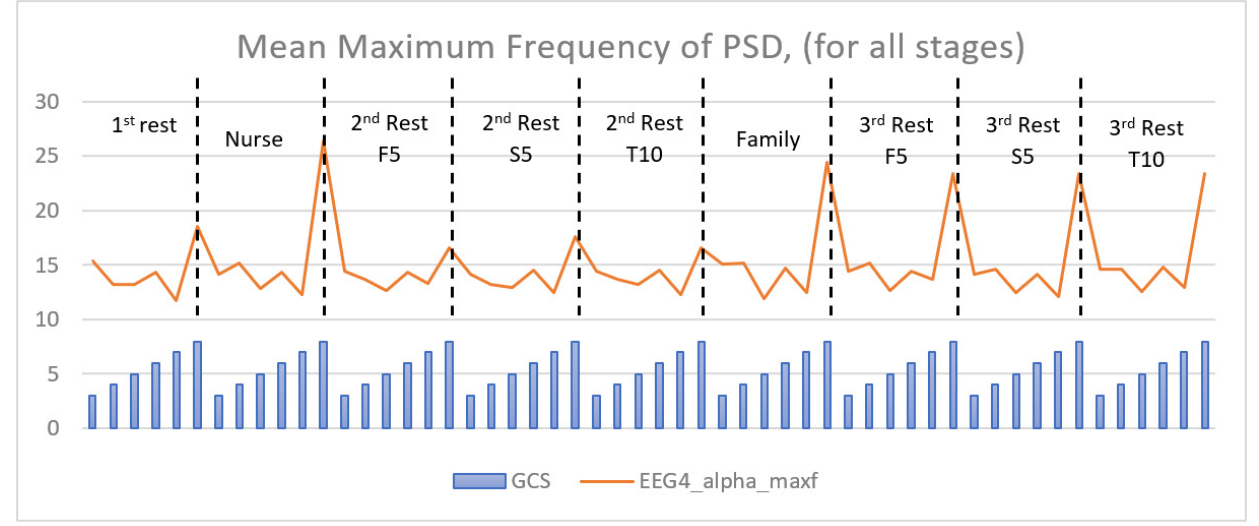
Figure 8. Mean values of the second feature (maxf) by different GCS groups. EEG4 represents the P3-P4 channel. Blue bars represent GCS 3, 4, 5, 6, 7, and 8, respectively, for each stage. F5: first five minutes, S5: second fi ve minutes, T10: total ten minutes.